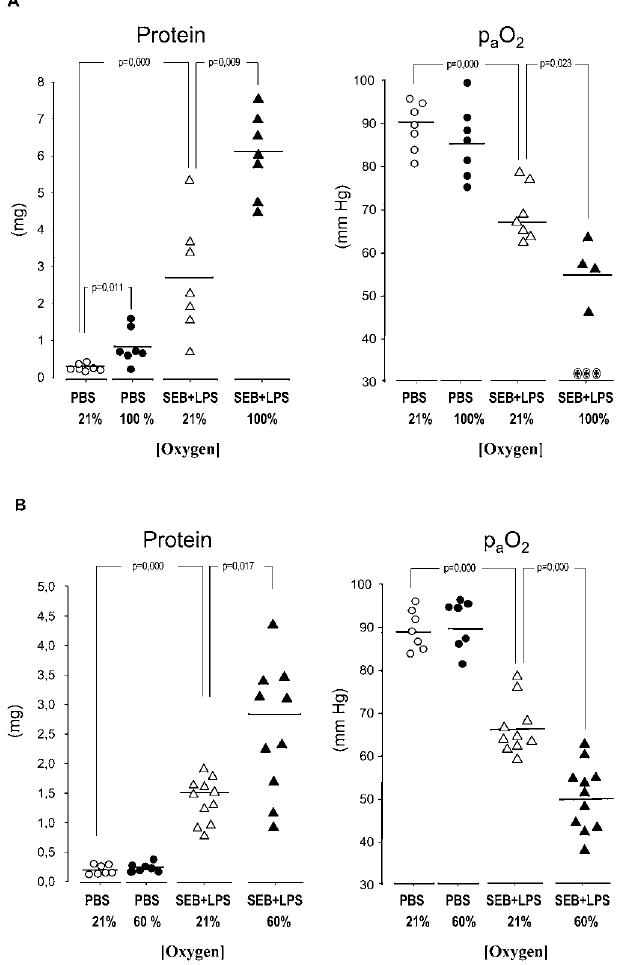
Figure 2. Exacerbation of Inflammatory Lung Injury after Exposure of Mice to Different Concentrations of Oxygen (A) Enhanced lung vascular permeability (left graph) and impairment of lung gas exchange (right graph) in mice breathing 100% O 2 upon induction of acute lung injury. Following IT injection of mice with SEB and LPS, animals breathed 21% or 100% oxygen. After 48 h, lung vascular permeability and lung gas exchange were determined by the amount of protein recovered by BAL or by measuring pO 2 values in arterial blood drawn, respectively, 15 min after return of mice to normal atmosphere. During this equilibration period, three out of seven mice previously exposed to 100% oxygen died, so that no arterial blood gas analyses could be performed, but BAL protein concentrations were determined immediately thereafter. (B) Increased lung vascular permeability (left graph) and impairment of lung gas exchange (right graph) in mice with acute lung injury even upon exposure to lower levels of oxygen (60%), which are considered clinically safe in humans. Experimental conditions were the same as in (A), except oxygen concentration was 60% instead of